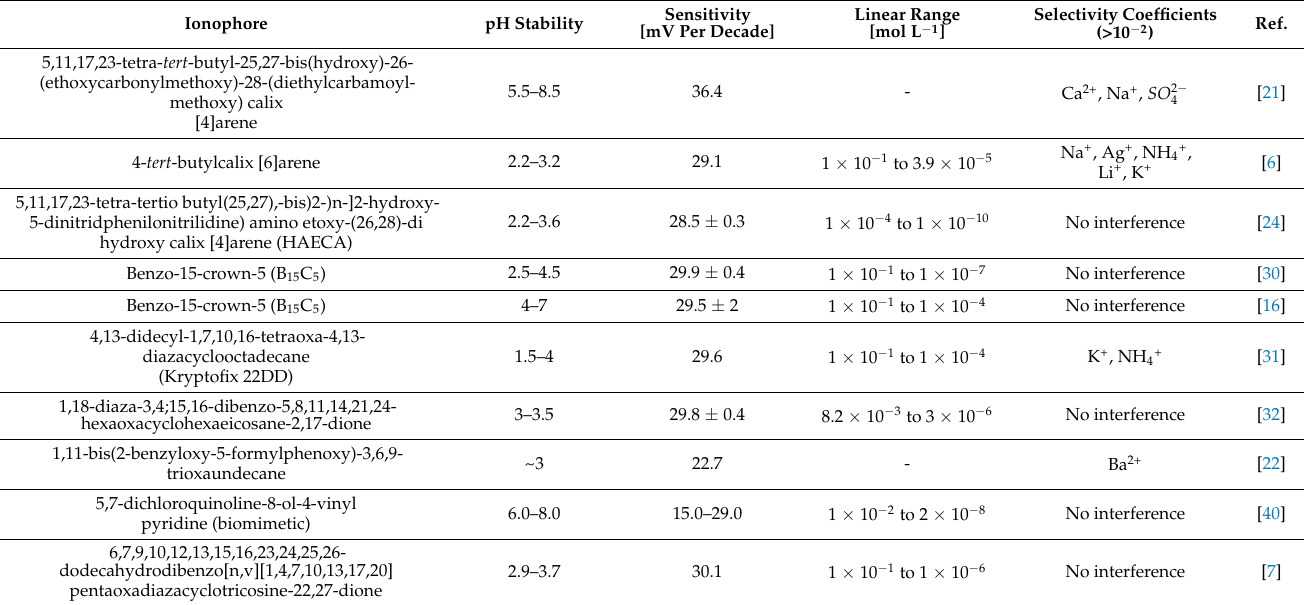
Table 2. An overview of uranium detection by PVC-based membrane electrodes with macrocyclic ligand-based ionophores.